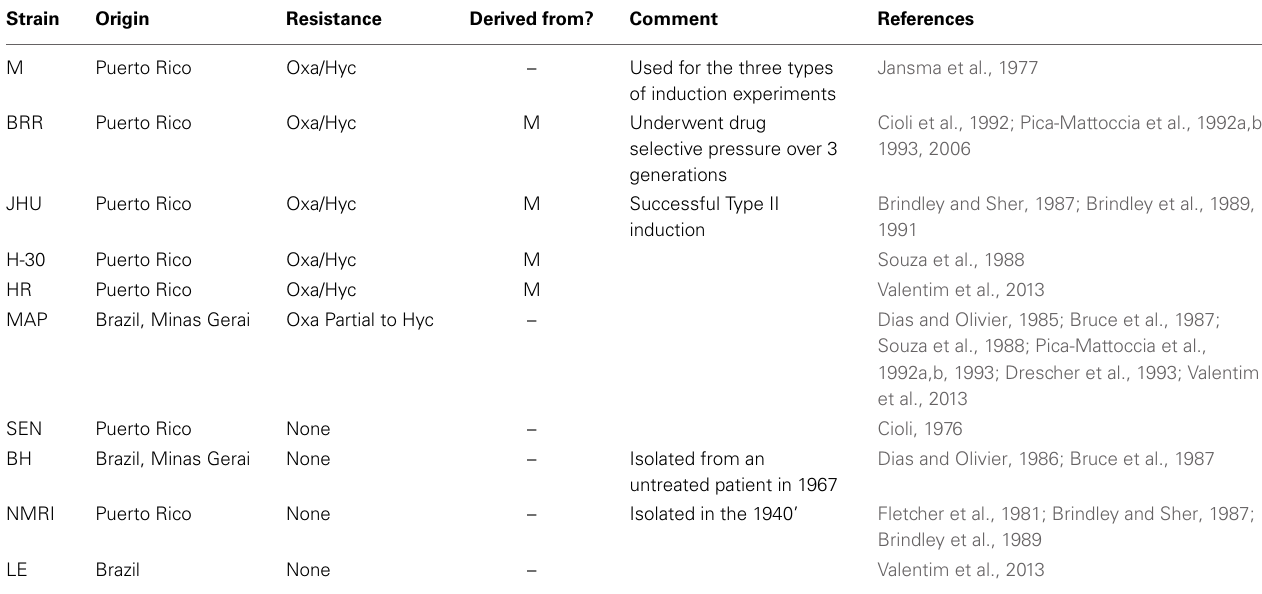
Table 1 | Origin and resistance phenotypes of the most commonly used strains in the